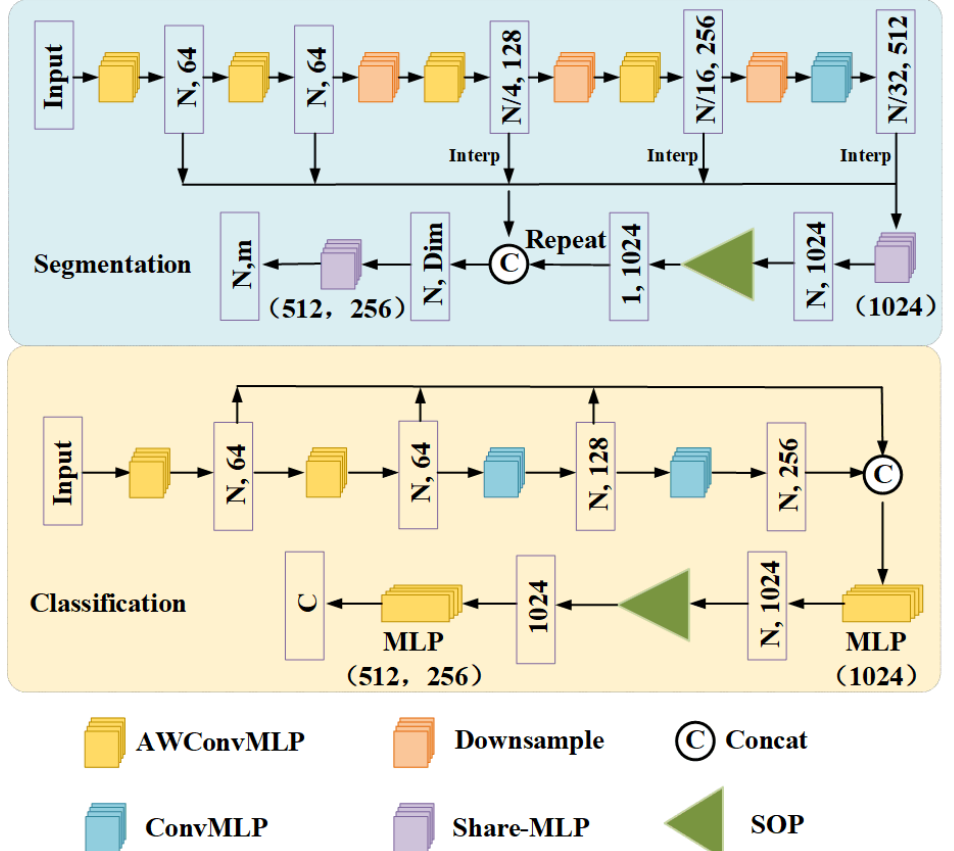
Figure 2. The GC-MLP network structure is used to classify and divide tasks. The convolution of the convolution layer is a standard convolution operation. The first two layers of the segmentation model use normal AWconvMLP, the last three layers use downsampling and AWconvMLP structures, and finally use linear interpolation and skip link connection methods to upsample and aggregate the features of each layer. Among them, Dim represents 2112 dimensions (2048+64 (category vector)) in partial segmentation, Dim represents 2048 dimensions in semantic segmentation and the classification model uses dynamic